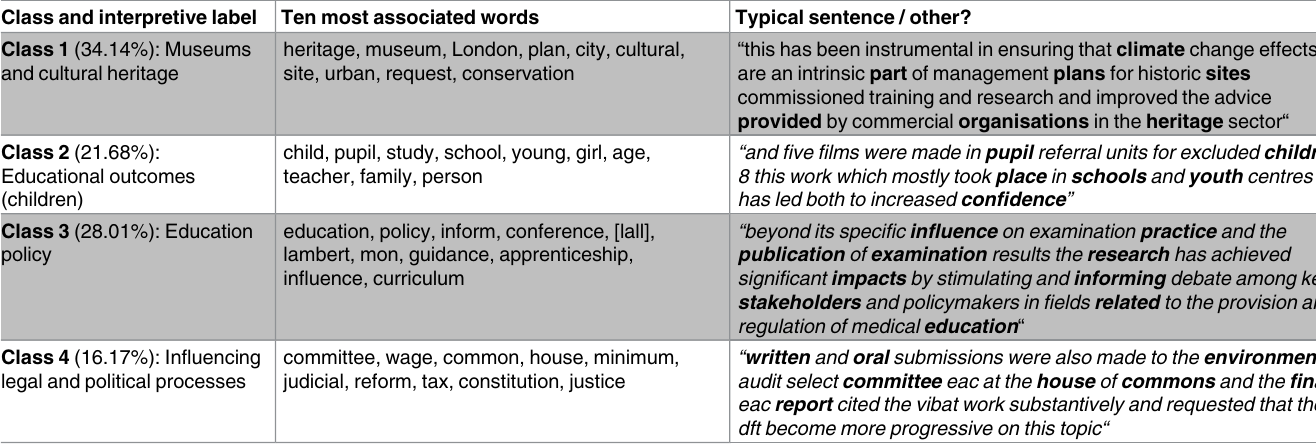
panels, only Panel B exhibited strong impact in the area of enterprise / business. This suggests that impact was being interpreted by the researchers and their institutions and not just fol- lowed from the guidelines. Panel A: Life Sciences. The analysis of 122 UCL impact case studies submitted to Panel A produced three distinct classes, or interpretations of type of impact as described in Table 4. Panel B: Physical Sciences. The analysis of 50 UCL impact case studies submitted to Panel B produced five distinct classes, or interpretations of type of impact (Table